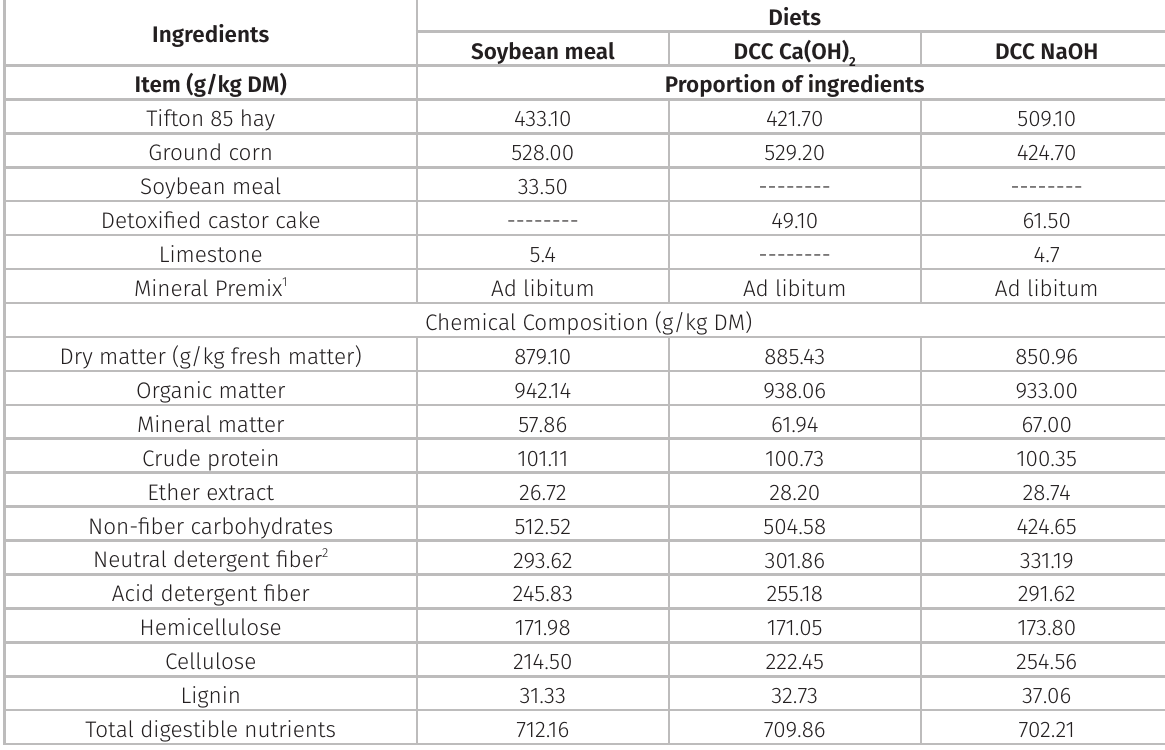
Table II. Proportion of ingredients and chemical composition of the experimental diets.